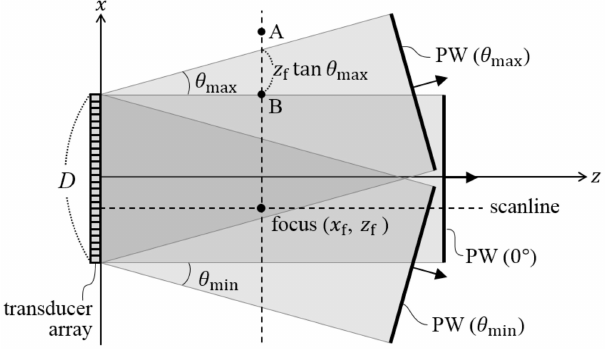
Figure 2. Collimated beam areas (gray shaded areas) of PWs with steering angles of θ max , 0 ◦ , and θ min (from top to bottom). The points, A and B, are located at the region where none of PWs pass and the region where half of transmitted PWs propagate,